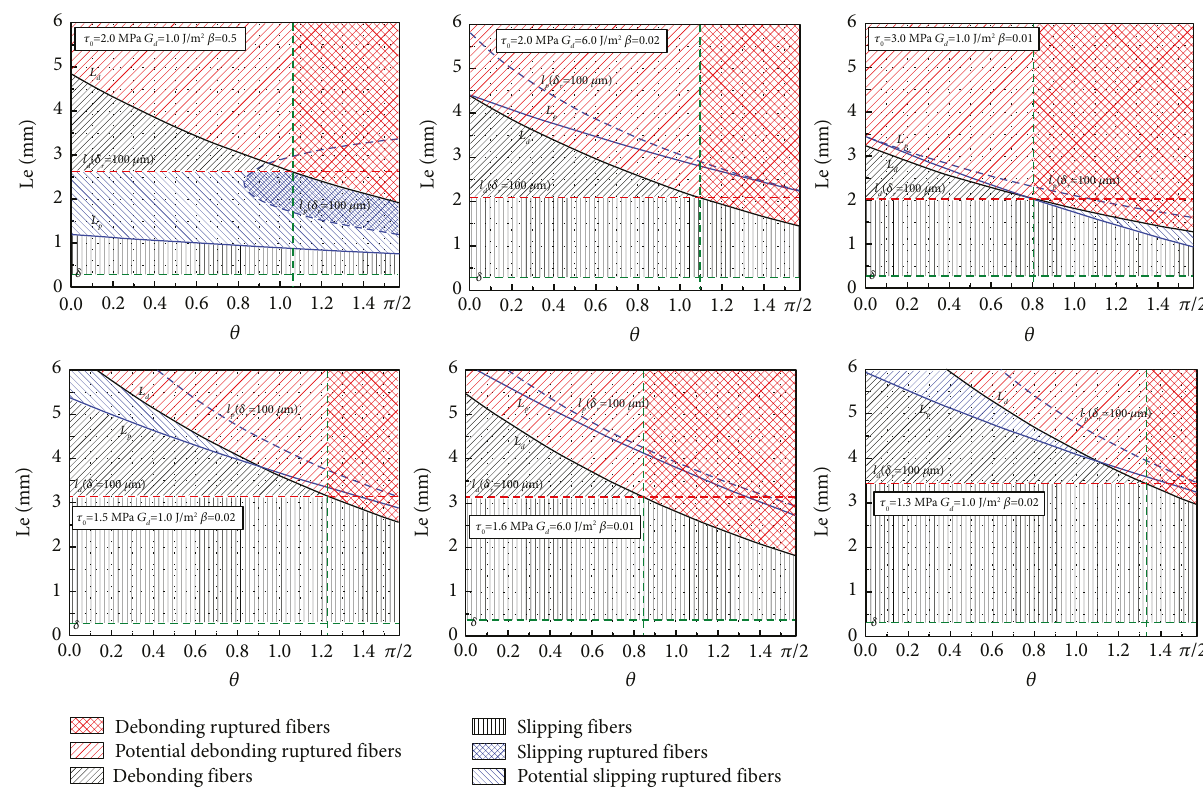
Figure 11: Fiber rupture analysis with different interfacial parameters when δ � 100 μ l ( δ ) and l ( δ ) represent the upper part and lower p 1 r p 2 r part of the l p ( δ r ) curve, respectively. As shown in Figure 12, l ( δ ) may be greater than L p 1 r f /2 during crack propagation.